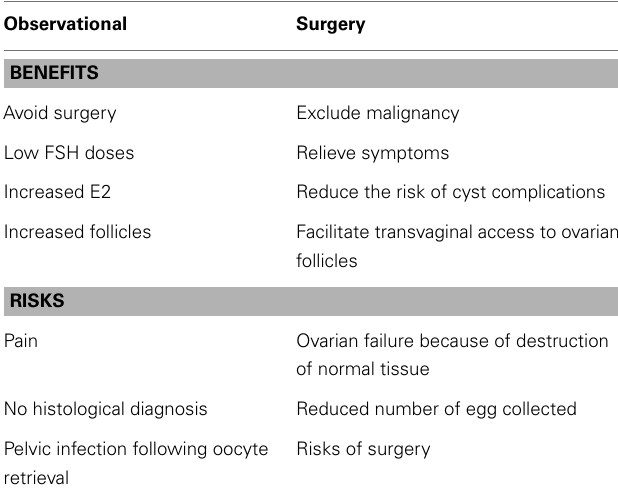
Table 2 | Risk and benefits of observational and surgical management of endometriomas (19)